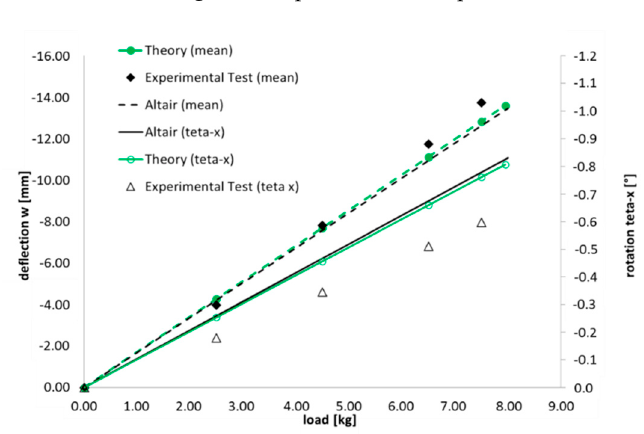
Figure 8. Experimental set-up.